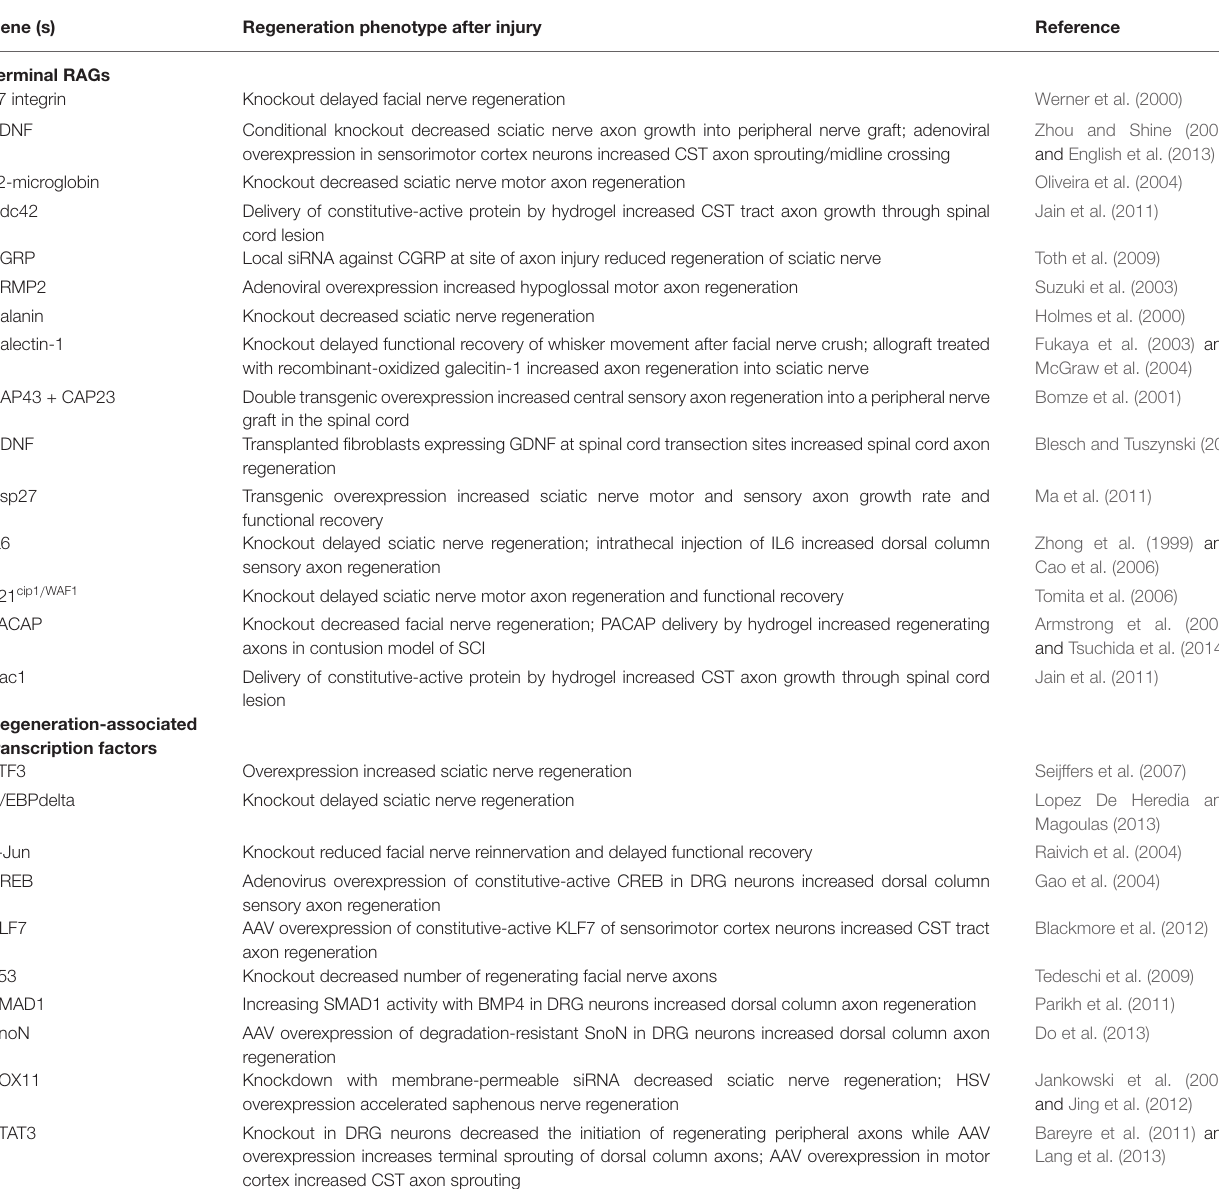
TABLE 1 | Regeneration-associated transcription: RAGs and genetic manipulations that alter axon regeneration after injury in vivo . Gene (s) Regeneration phenotype after injury Reference Terminal RAGs α 7